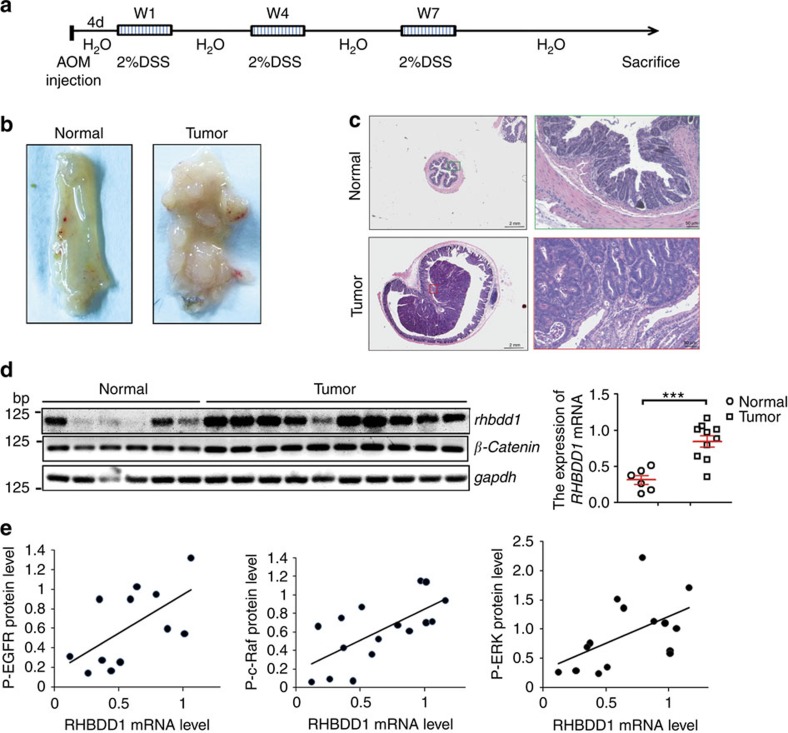
RHBDD1 expression in a murine model of colitis-associated colorectal cancer and its correlation with the EGFR signalling pathway.(a) Schematic representation of AOM and DSS treatment. (b) Representative gross appearance of the colons of normal and AOM/DSS-treated mice. (c) Representative images of colon tissues stained with H&E. (d) RHBDD1 is upregulated in the murine model of colorectal cancer. RHBDD1 and β-catenin mRNA expression was analysed by RT–PCR using GAPDH as a loading control. The data are presented as means±s.d., N=16, the Student's two-tailed t-test, ***P<0.001. (e) The level of RHBDD1 mRNA expression is positively correlated with that of phosphorylated EGFR, c-Raf and ERK1/2. The phosphorylation levels of EGFR, c-Raf and ERK1/2 were analysed by western blotting using GAPDH as a loading control. The relative level of RHBDD1 expression was plotted against the phosphorylation levels of EGFR, c-Raf or ERK1/2.